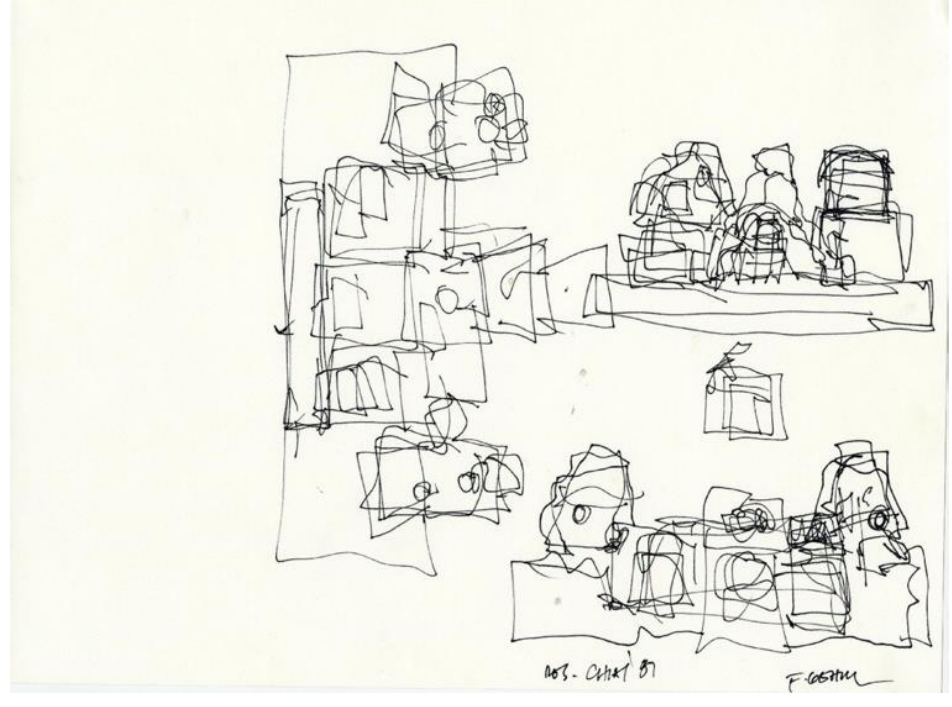
Figure 5. Frank Gehry, project sketch for Chiat Residence, Sagaponeck, New York, 1986 © Frank O. Gehry. Frank Gehry papers, Series I: Architectural Projects, Getty Research Institute, Los Angeles, CA. Digital image courtesy of the Getty Research Institute Digital Collections.